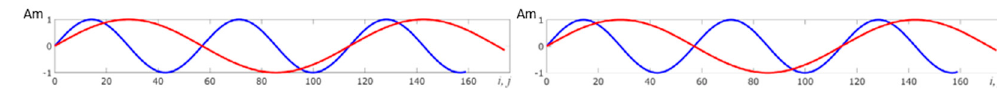
Figure 6. Model experiment on separation of factors using the matrix estimation method. The red color shows the receiver factor and the blue color shows the source factor.